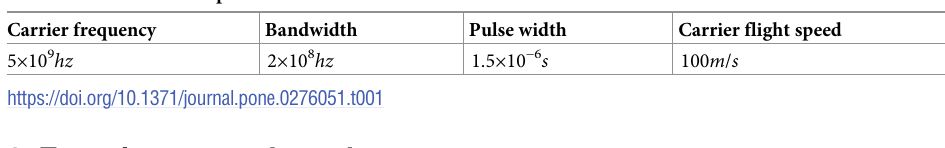
Table 1. Main waveform parameters.